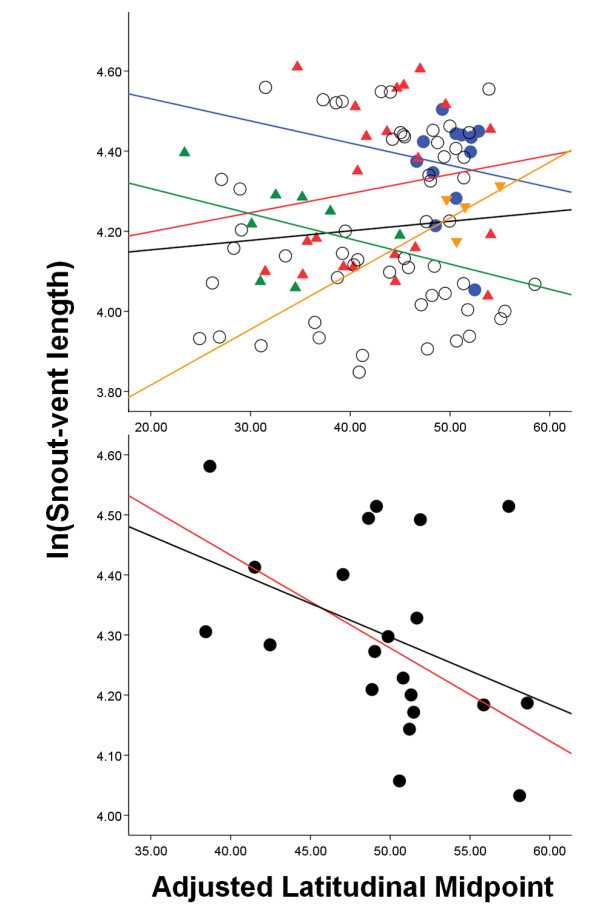
Linear regressions of raw data for ln(snout-vent length) against adjusted latitudinal midpoint in the six main clades forming the Liolaemus genus. Top: regressions for the clades chiliensis (black), Donosolaemus-magellanicus including outliers (blue; slope from analysis excluding outliers not shown, as it provided identical qualitative results), fitzingerii (red), lineomaculatus (orange), and wiegmannii (green). Bottom: regressions for the clade montanus including (black) and excluding (red) outliers.